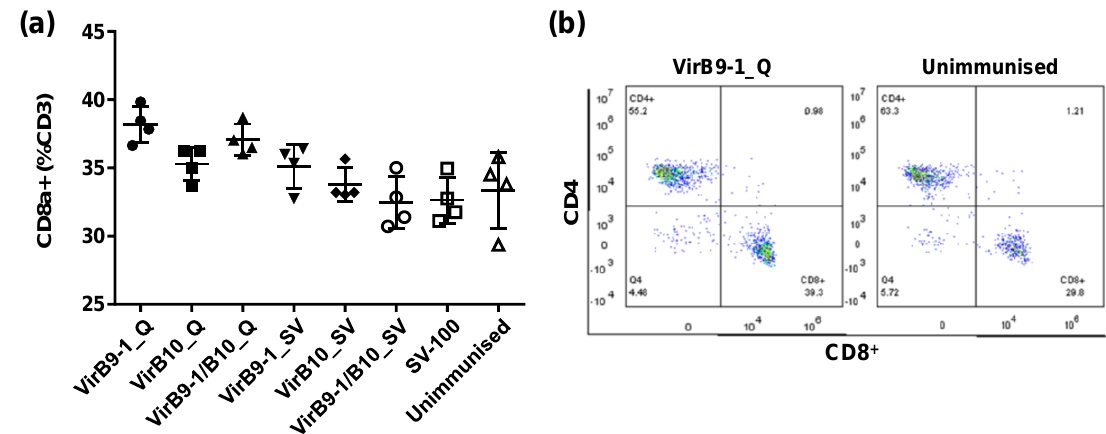
Figure 7. Fluorescent activated cell sorting (FACS) of spleen cells from immunised mice showing CD8 + population of CD3 in treatment groups. Gating strategies for the spleen inflammatory infiltrate. Cells were first gated on size SSC-A: Side Scatter of cells-Area vs. FSC-A: Forward Scatter of cells-Area, and viability DRAQ5 (The Thermo Scientific DRAQ5™ Fluorescent Probe) expression, not shown, then leukocytes (CD45 + cells) were sub-gated for CD4 + and CD8 + population. ( a ) CD8 + population of CD3 in all treatment groups; ( b ) Gating strategies of VirB9-1_Q and unimmunised groups.